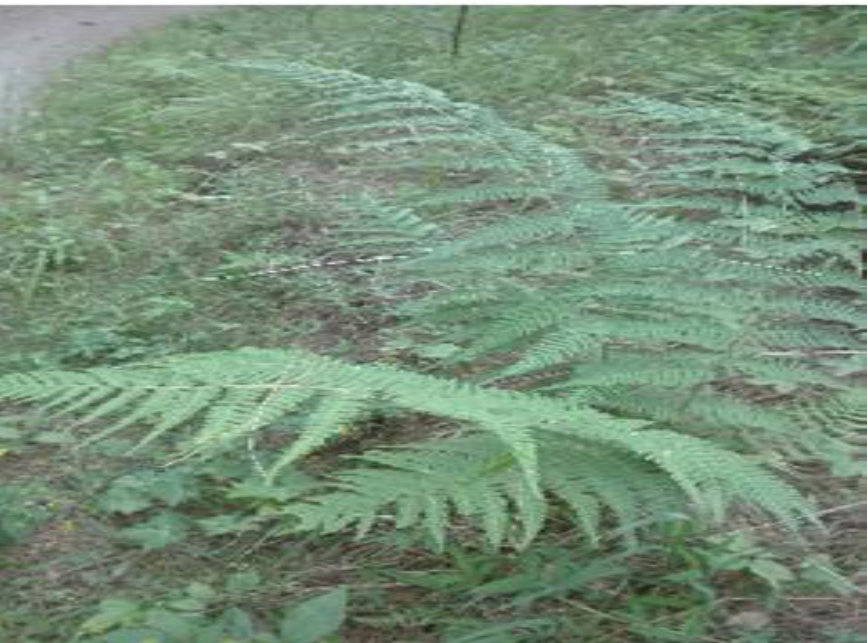
Figure 1. Dryopteris ramosa (Hope) C. Chr., growing at latitude 33°52 ′ 41.58 ″ N and longitude 73°7 ′ 8.47 ″ E (longitude and latitude were determined by using Google Earth pro 2002 free software). 73 ◦ 7 (cid:48) 8.47 (cid:48)(cid:48) E (longitude and latitude were determined by using Google Earth pro 2002 free The photograph was taken by Muhammad Ishaque.